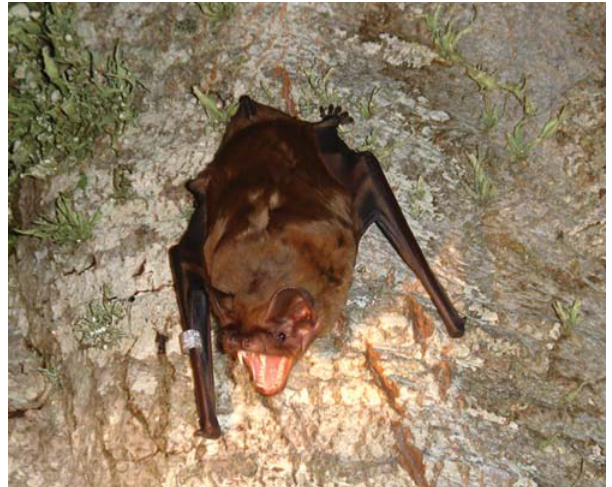
Figure 1. Nyctaluslasiopterusshowing its impressive teeth to the researchers.